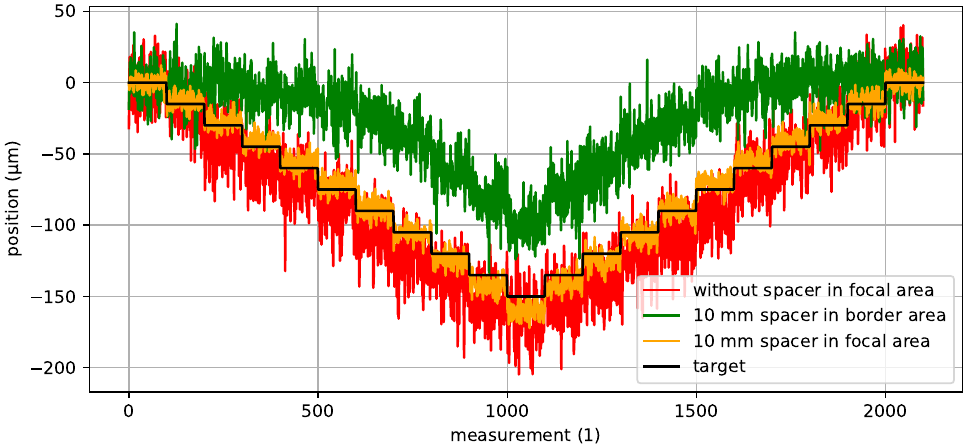
Figure 11. Comparison of the estimated poses with a 10mm spacer and without for a staircase motion in z -direction with a step size of 15µm in the focal and border